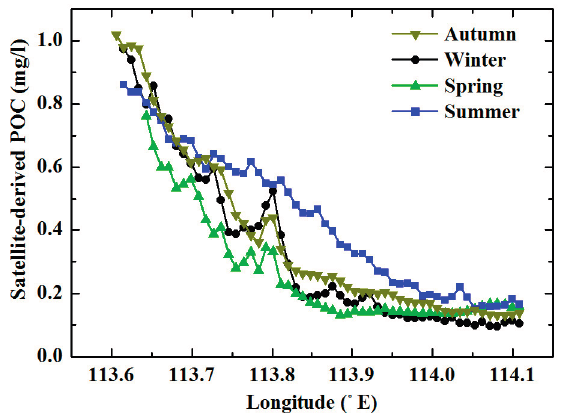
Figure 6. Seasonal POC concentrations (mg/L) along the section defined in Figure